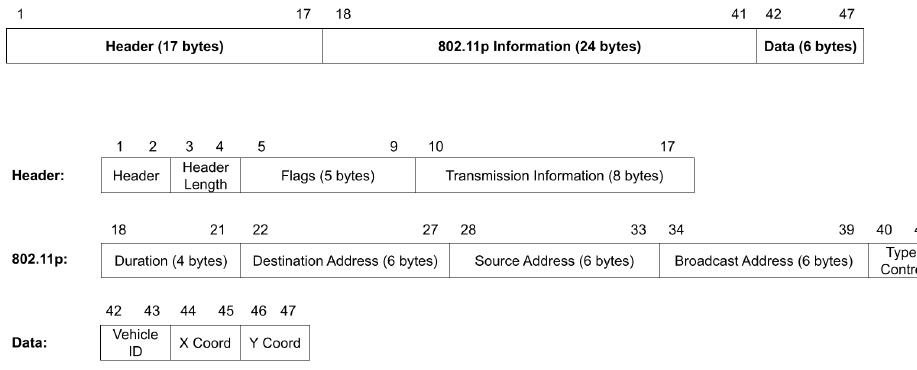
Figure 12. Layout of the transmitted 802.11p frame. The top demonstrates the general layout of the three main sections of the frame. Below that is each of the three sections expanded upon: the header, the 802.11p information, and finally the data.